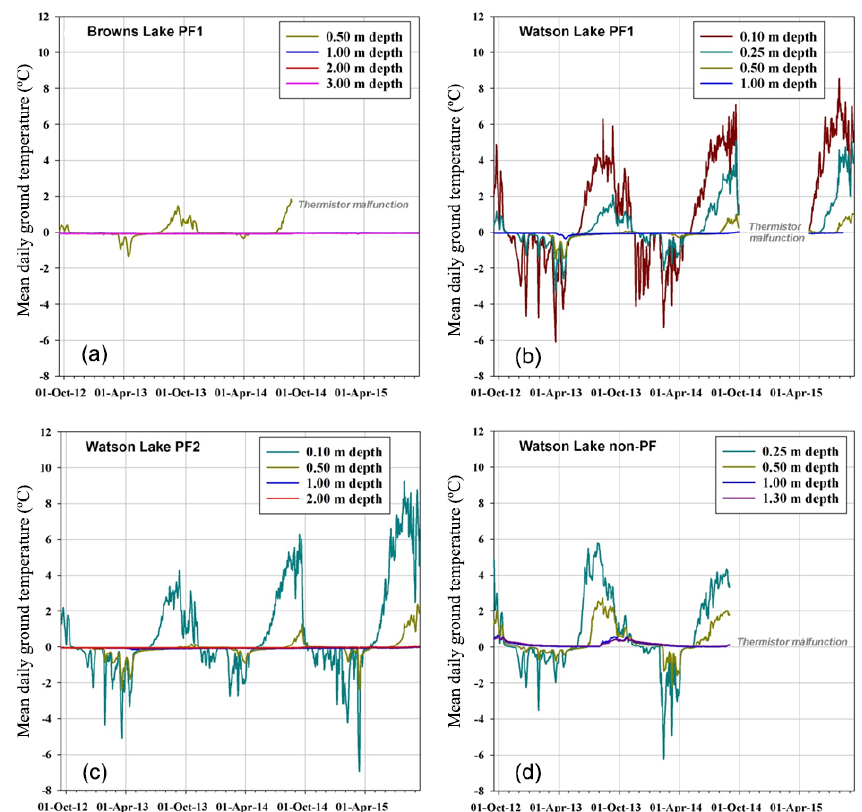
Figure 5. Mean daily ground temperature data plots for the four shallow boreholes in the western Kenai Peninsula lowlands for the period of 16 September 2012 to 15 September 2015: (a) Browns Lake PF1 site, (b) Watson Lake PF1 site, (c) Watson Lake PF2 site, and (d) Watson Lake non-PF site. All axes scales are the same but sensor depths vary among sites based on site characteristics. Missing data indicate sensor or thermistor